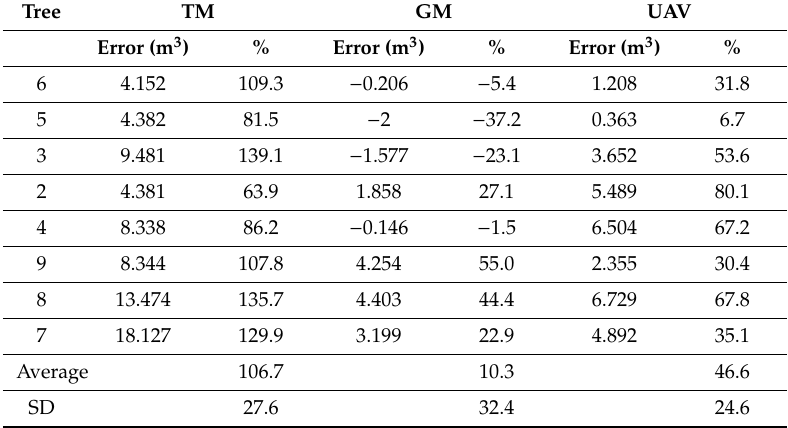
Table 3. Volume error with respect to the reference method